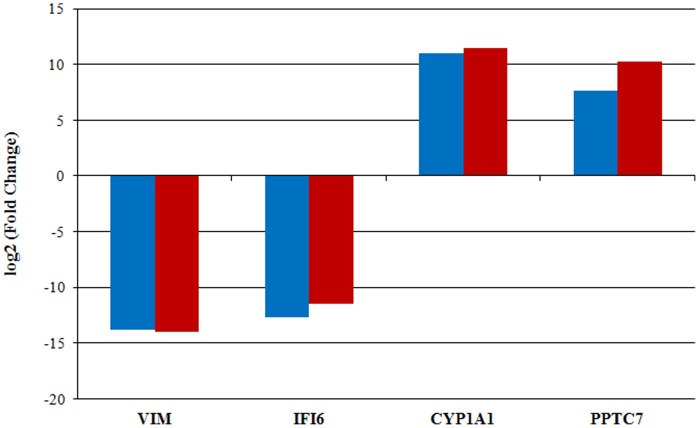
Fold changes of four differentially expressed genes measured by RNA-Seq (blue) versus qRT-PCR (red).Bars above the X-axis denote genes with higher expression in the methionine-rich treatment while bars below the X-axis denote genes with higher expression in the in control treatment. Importantly, IFI6 was not expressed in methionine-rich pool and hence a fold change was assigned based on the detection threshold of the equipment.